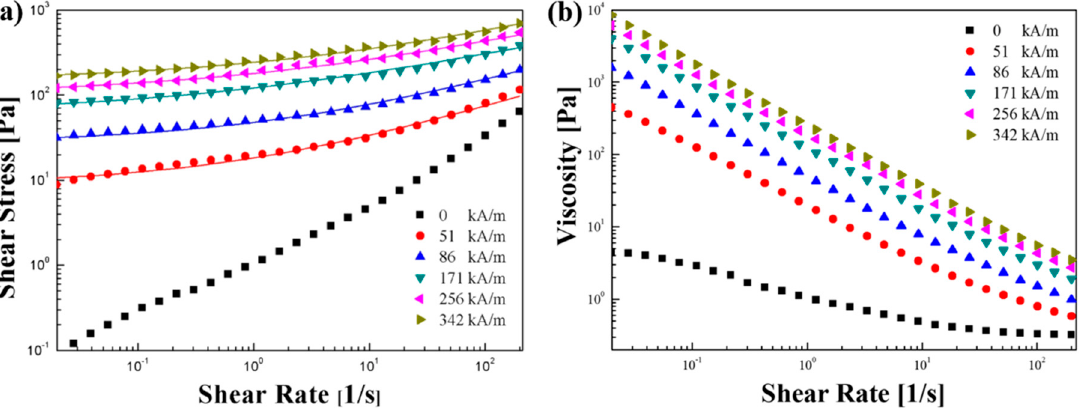
Figure 6. Flow curve for Fe 3 O 4 /POA (10 vol %) MR suspension under different magnetic field strengths. ( a ) Shear stress and ( b ) shear viscosity as a function of shear rate.